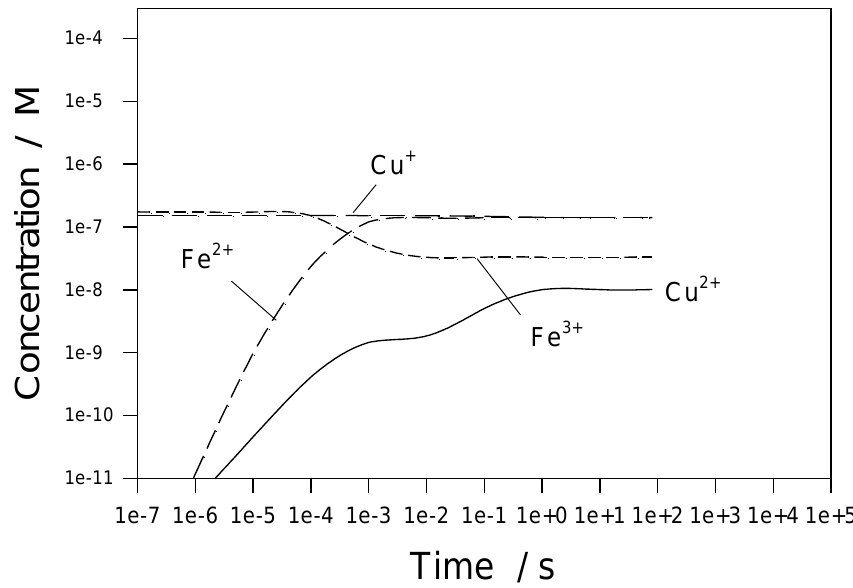
Figure 35 . Predicted concentrations of metal species in an average equatorial module as a function of time. Initial conditions are [Cu + ] = 10 ppb, [Fe 3+ ] = 10 ppb, and [Cu 2+ ] = [Fe 2+ ] = 0. [H 2 ] Inlet = 1 cc(STP)/kg H 2 O.